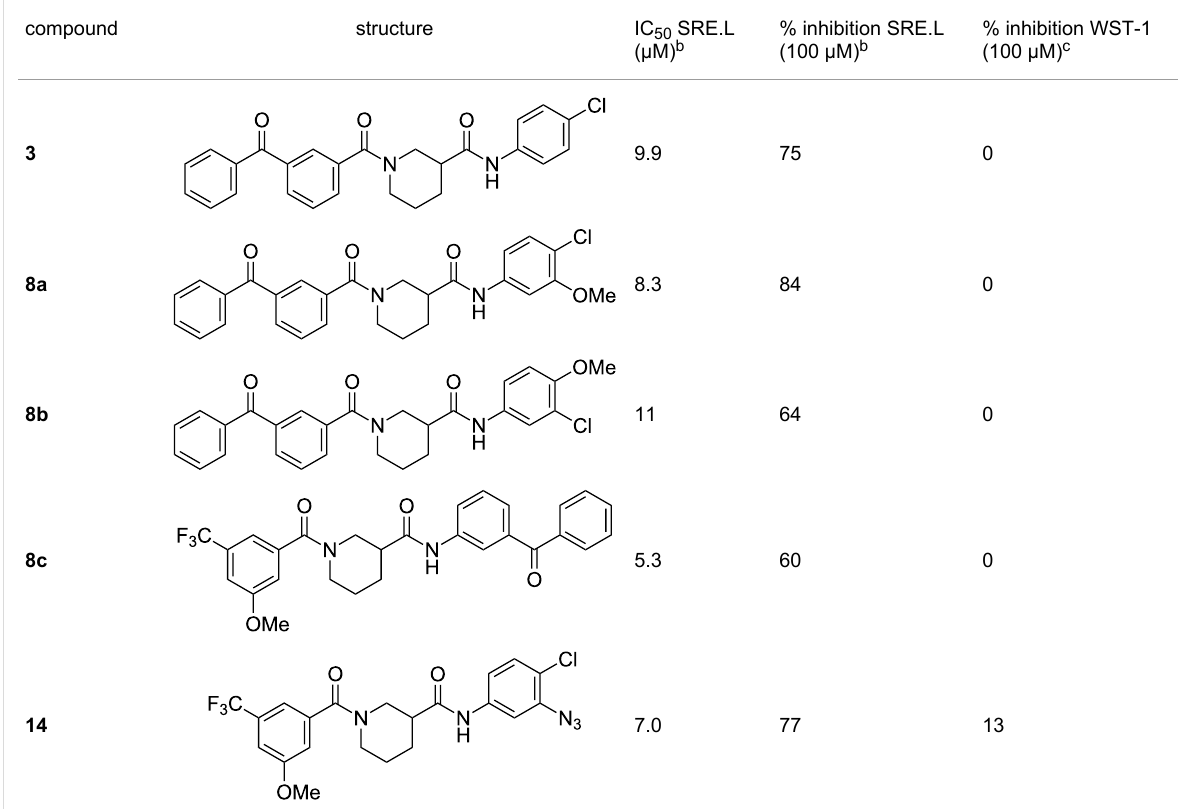
Table 1: Effects of model photoprobes on transcription and cytotoxicity in PC-3 cells a .